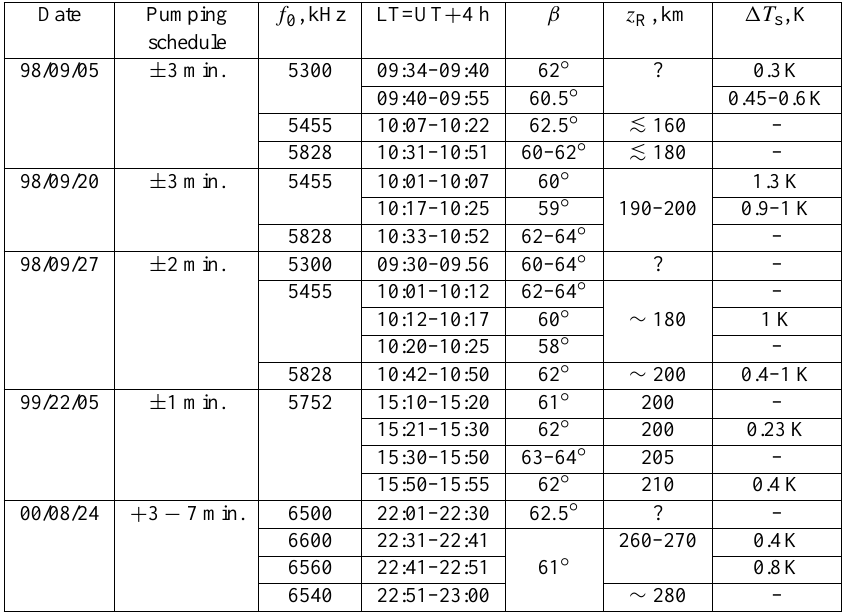
Table 1. Results of UHF SEE observation at f = 598MHz. f 0 is the pump frequency, β is the elevation angle of RT-15 antenna; z R is the reflection altitude of the pump wave, “?” means that z R was not obtained in this particular measurements, 1T s is the signal temperature enhancement during pump wave “on”